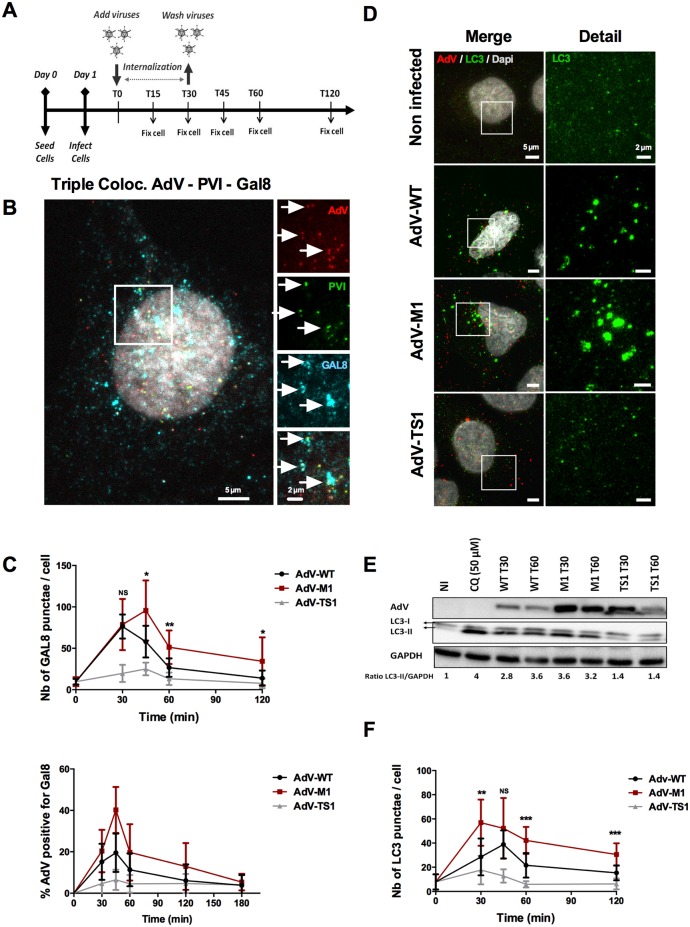
AdV induced membrane damage causes selective autophagy.(A) Schematic representation of the experimental setup for quantitative immune fluorescence analysis. Cells grown on coverslips were infected with virus at 37°C followed by inoculum removal after 30min. Coverslips were collected and fixed at indicated time points for quantitative immunofluorescence analysis as detailed in SI. (B) U2OS cells were infected with WT fluorescently labeled viruses (red signal) and fixed at 30min post infection and stained with anti PVI antibodies (green signal) and anti Gal8 antibodies (cyan signal). The insets to the right show triple colocalization (AdV+VI+Gal8) indicated by arrows (white signal). (C) U2OS cells were infected with fluorescently labeled WT (black line), M1 (red line) or TS1 viruses (gray line) as outlined in (A). At each time points cells were fixed and stained for Gal8. The top panel shows the absolute number of Gal8 punctae per cell, the bottom panel the percentage of Gal8 positive particles. Error bars show cell-to-cell variations (n>10 cells; NS: no significant; *: P<0.05; **: P<0.01; ***: P<0.005 and errors bars are standard deviation). (D) Representative confocal images of cells infected with different AdV showing virus induced autophagy. Conditions are indicated to the left of each row. Cells were fixed at 30 minutes post infection and stained with anti-AdV (first column, red signal) and anti-LC3 (first and second columns, green signal). (E) Infected U2OS cells were analyzed by western blot at 30 min (T30) and 60 min (T60) post infection using LC3 and GAPDH specific antibodies. As a positive control cells were treated with 50μM of CQ during 3hours. The LC3 signal depicts unconjugated (LC3-I) or PE-conjugated (LC3-II) LC3. Note that upon PE conjugation LC3 has a higher mobility in SDS-PAGE. The ratio of LC3II/GAPDH normalized to the non-infected condition was determined and is given below the panel. (F) Experiment as in (C) stained with anti-LC3 depicting the absolute number of LC3 punctae per cell.